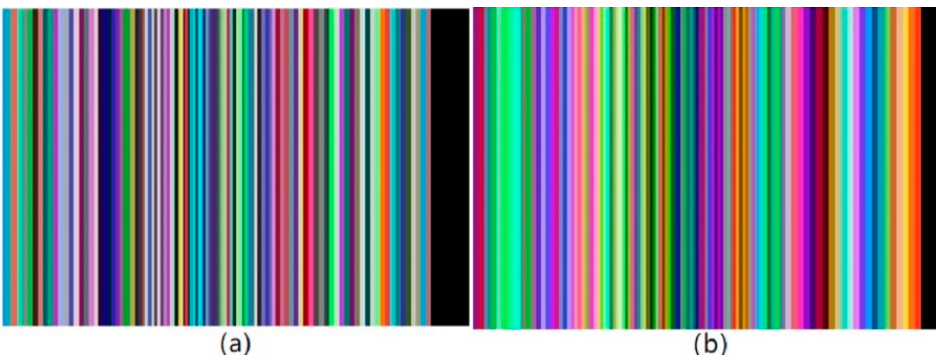
Figure 11. Hadamard masks: ( a ) traditional Hadamard mask ( b ) new Hadamard mask. They are produced by the same order of 107.